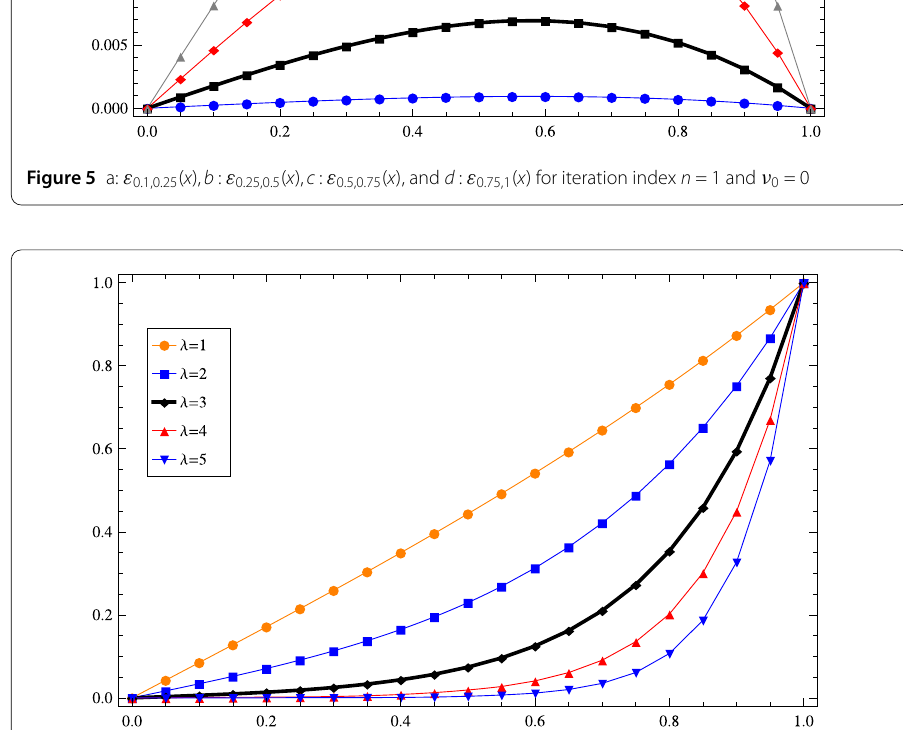
Figure 6 Plot of numerical solution of approach I for ν 0 = 0, λ = 1, ... ,5, and n =